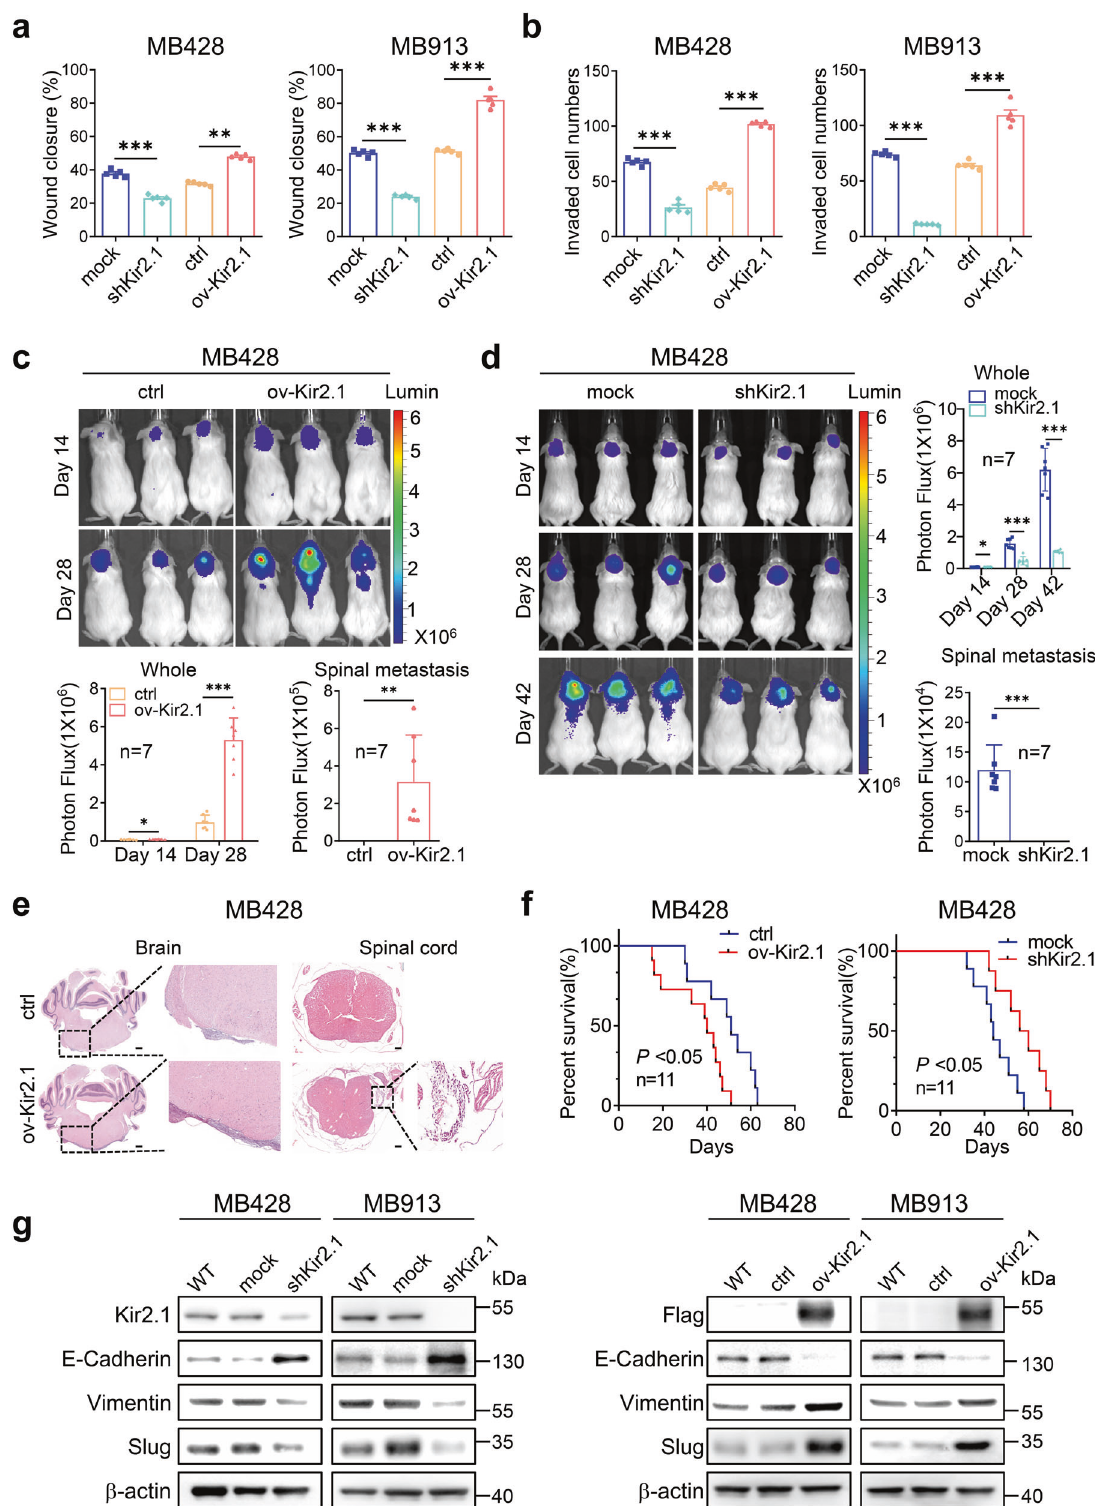
with Kir2.1-knockdown also exhibited decreased invasive capabil- ity, while opposite results were obtained from Kir2.1-overexpres- sing MB cells (Fig. 2b and Supplementary Fig. 3b). Then the tumorigenic, invasive, and metastatic capacities of Kir2.1-over- expressing MB cells and paired control cells were examined by